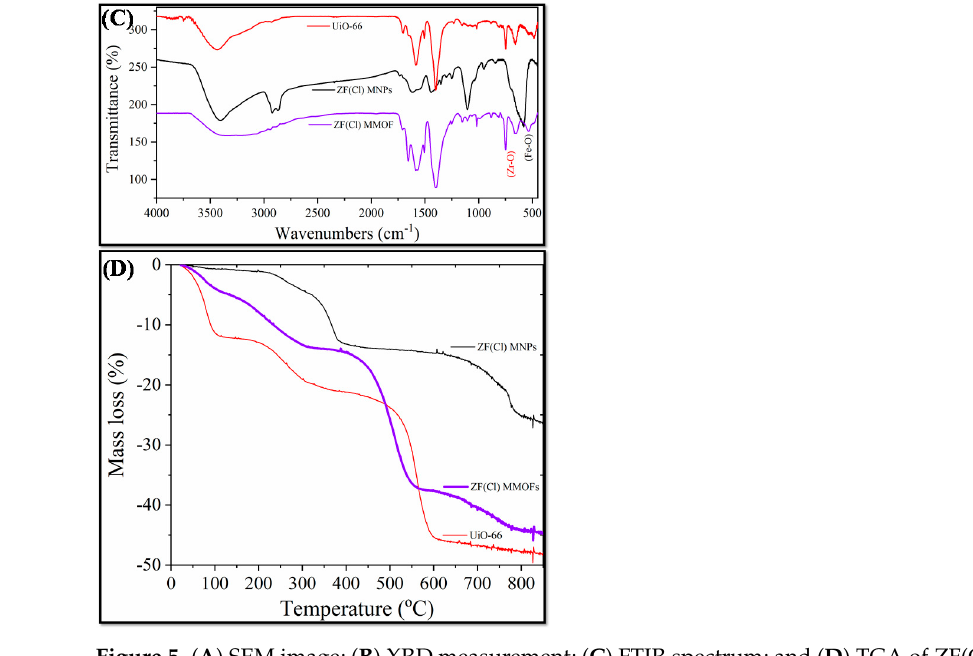
Figure 5. ( A ) SEM image; ( B ) XRD measurement; ( C ) FTIR spectrum; and ( D ) TGA of ZF(Cl) MMOF.